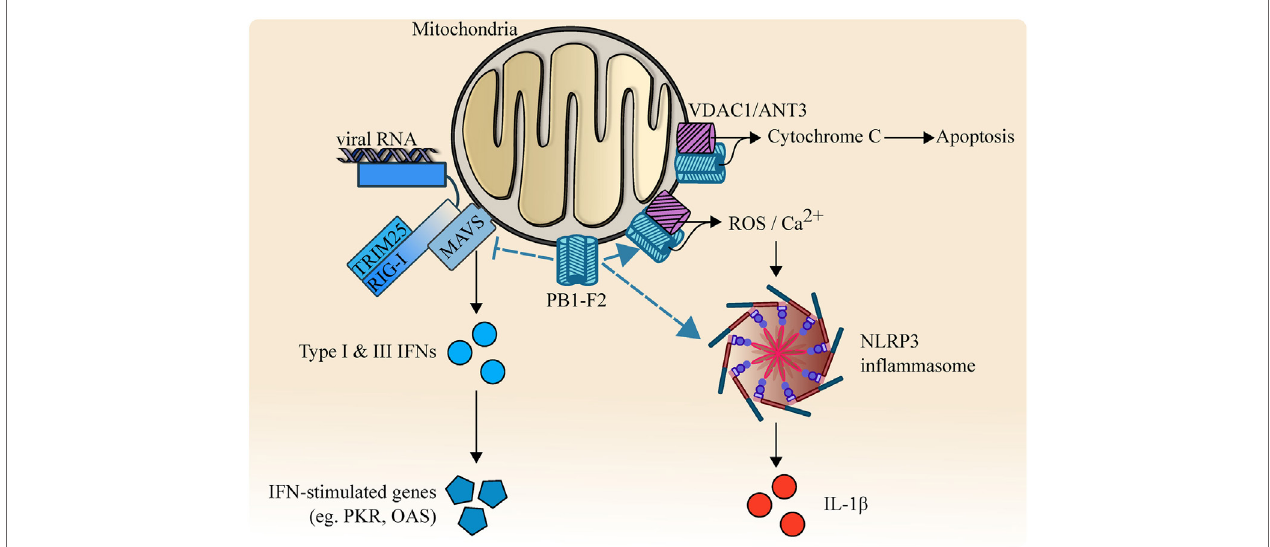
FigURe 3 | PB1-F2 and its multi-functional functions. PB1-F2 binds and inhibits RIG-I/TRIM25/MAVS-mediated signaling activity, reduces the transcription of type I, III interferon (IFNs), and the downstream induction of antiviral responses. PB1-F2 also forms fibrillar higher molecular weight aggregates that facilitate the release of pyrogenic IL-1 β by activating NLRP3-dependent inflammasome. Outer mitochondrial membrane ion channel voltage-dependent anion channel 1 (VDAC1) and adenine nucleotide translocator 3 (ANT3) are also targeted by PB1-F2, leading to increased release of cytochrome C, reactive oxygen species (ROS), and Ca 2 + . These result in apoptosis and NLRP3-inflammasome